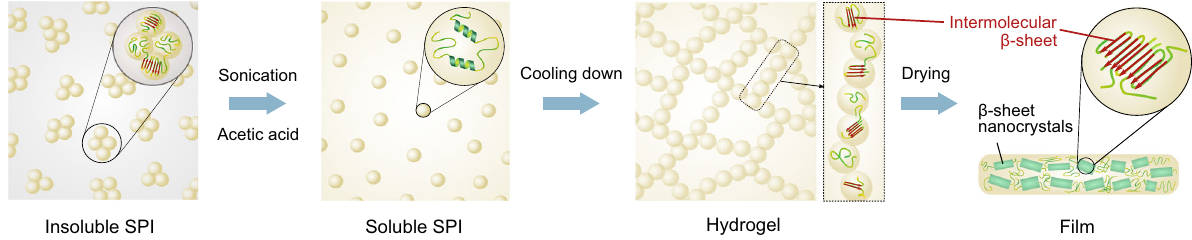
Fig. 3 Schematic representation of a proposed mechanism for the self-assembly of SPI. Through the ultrasonication treatment in acetic acid solution, the initially insoluble aggregates are solubilised and unfolded, making them avaialble to form new intermolecular interactions. Upon cooling down, the new intermolecular β -sheets structures are formed. The removal of solvent results in the formation of β -sheet nanocrystals within the fi